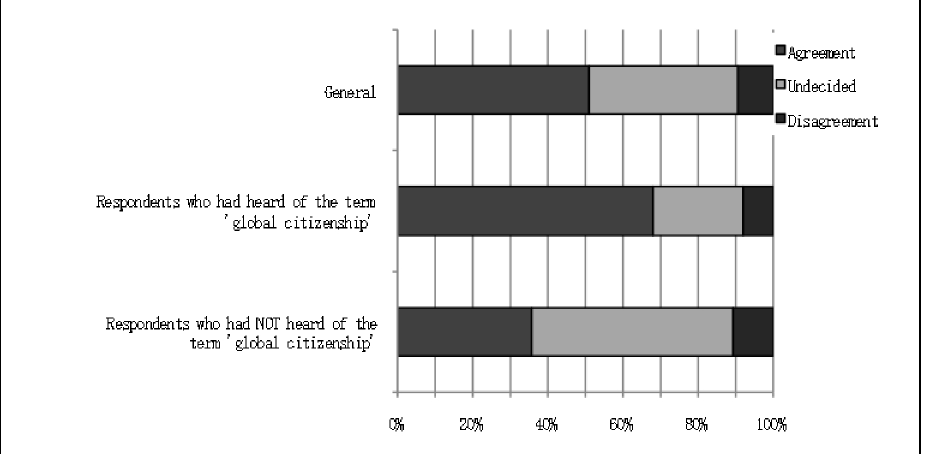
Figure 1: Attitude towards ‘globalisation is the reason for the emergence of global